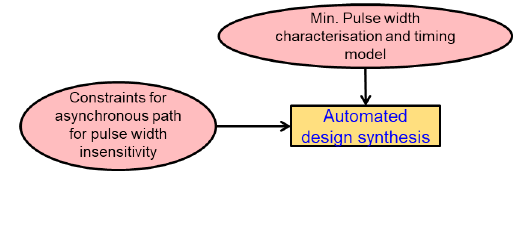
Figure 9. Design automation methodology